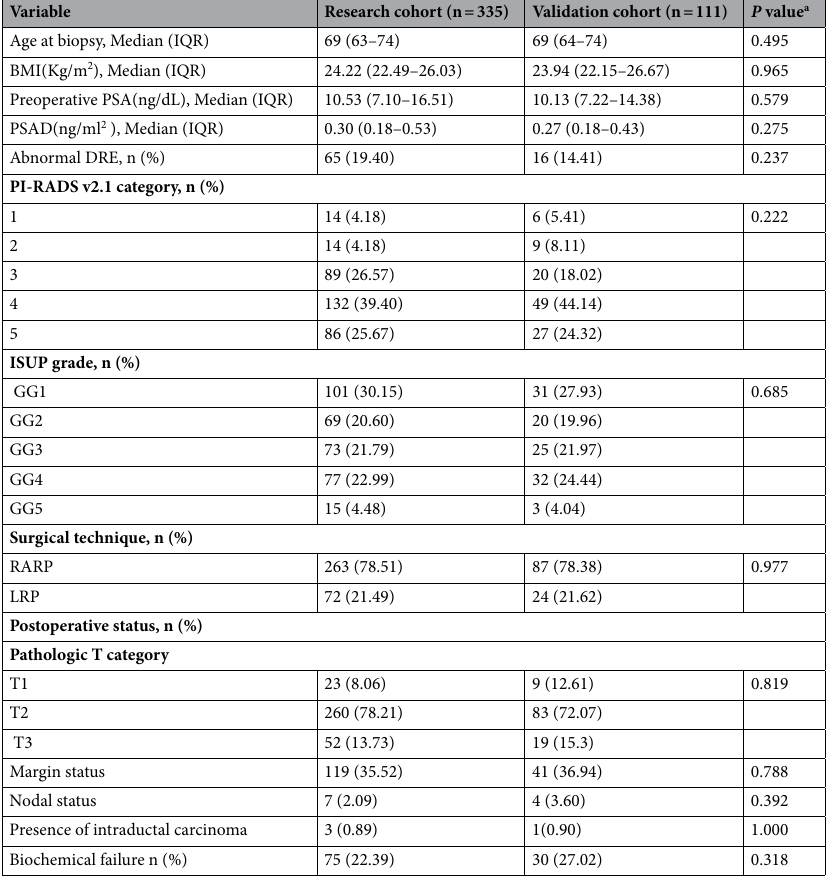
Table 1. Patient Demographics of Research and Validation Cohort. DRE Digital Rectal Examination; IQR Interquartile Range; PI-RADSv2 Prostate Imaging-Reporting and Data System version 2; PSA prostate-specific